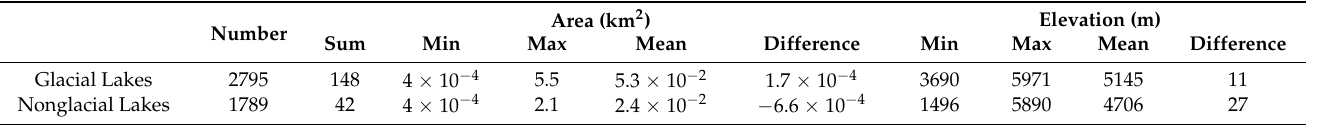
Table 5. Area, number, and elevation of the identified alpine lakes (glacial and nonglacial); Differences derived from median of all the identified and interpreted alpine